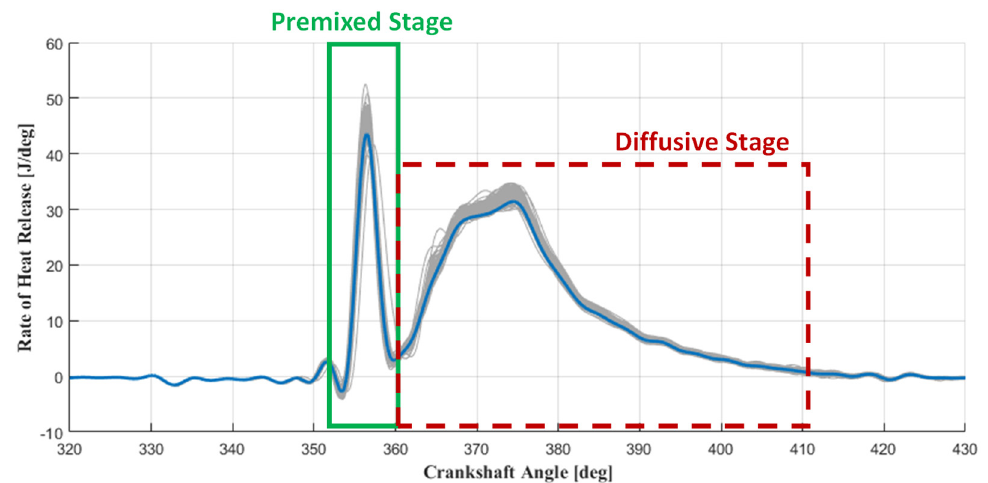
Figure 2. Rate of heat release curve testing GCI combustion at 12 bar of IMEP and 2000